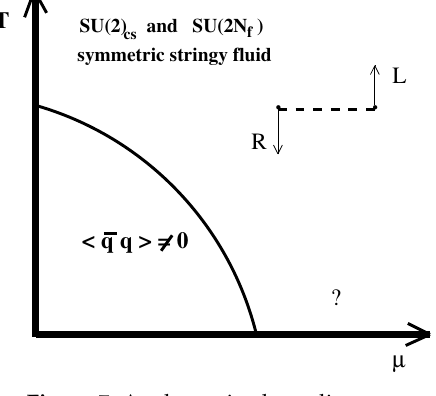
Figure 7. A schematic phase